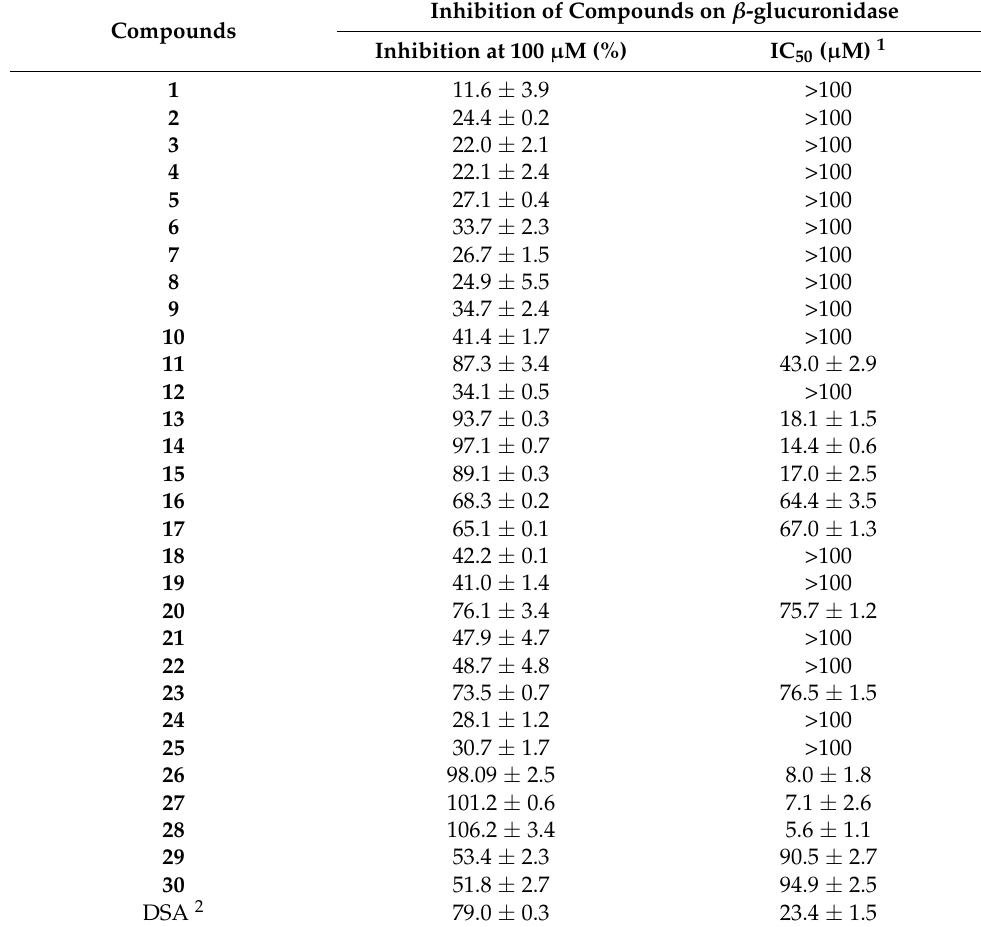
Table 1. Inhibitory activity of all isolated phloroglucinols 1 – 30 on β -glucuronidase.